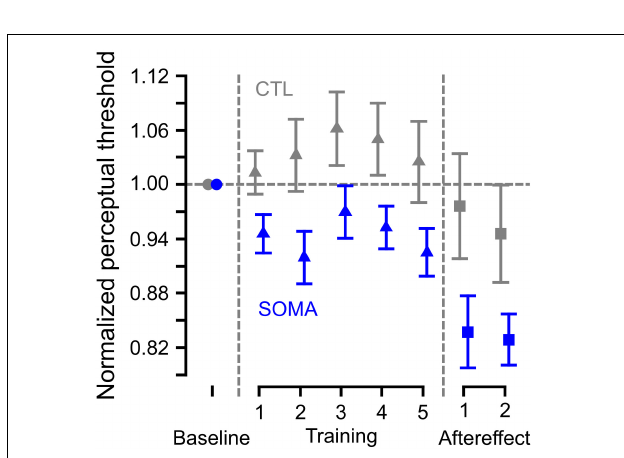
FIGURE 3 | Category boundary values normalized to the baseline category boundary over the course of the experimental procedures. Blue represents the somatosensory condition and gray represents the control condition. Error bars represent standard error across